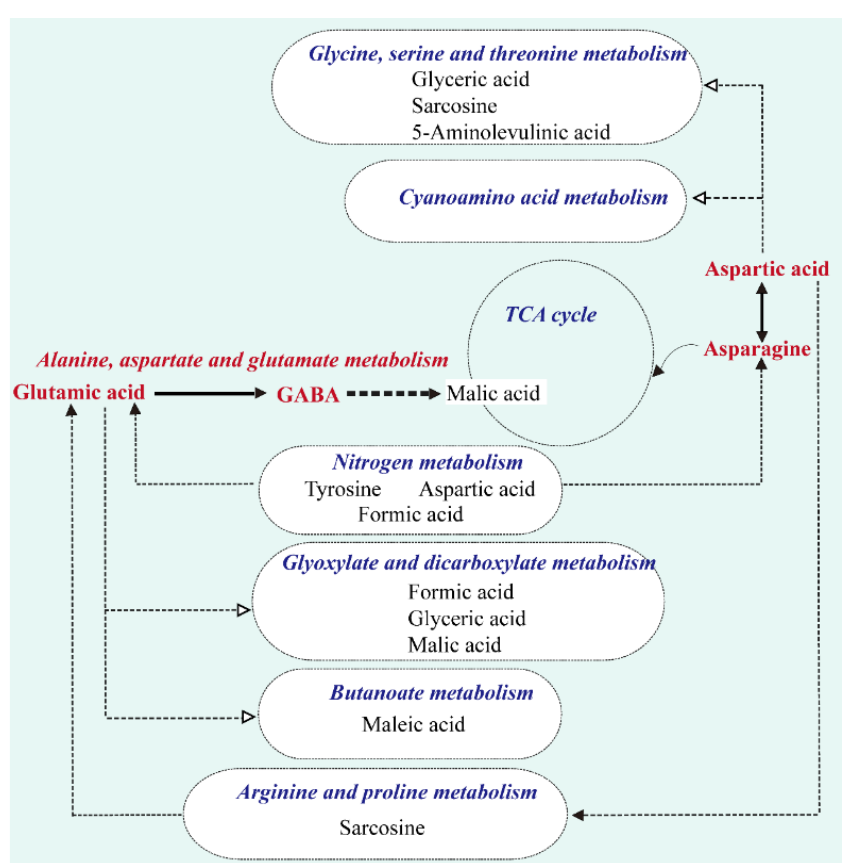
Figure 4. Metabolic network of significantly changed pathways and metabolites. Table 2. Differential metabolites screened from the E-METH and NE-METH groups. Among the above 55 differential metabolites in Table 3, 15 demonstrated normalized trends under induction by exercise and METH. As shown in Table 3, METH reduced the levels of linoleylcarnitine, hexanylcarnitine, sebacic acid, acetylcarnitine, maleic acid, 5-aminolevulinic acid, asparagine, malic acid, and N-acetylneuraminic acid and enhanced the levels of ethylmethylacetic acid, glyceric acid, isovaleric acid, erythronic acid, glutamic acid, and threonic acid. Exercise caused the opposite changes. Additionally, 22 metabolites showed the same trends under the induction of exercise and METH (Table 4). METH and exercise reduced the levels of pentadecanoic acid, DHA, 3-methyl-2-oxopentanoic acid, adrenic acid, phenylpyruvic acid, aspartic acid, suberic acid, DPAn-6, alpha-ketoisovaleric acid, dodecanoic acid, dihomo-gamma-linolenic acid, tyrosine, oleic acid, and DPA but increased the levels of carnitine, dodecanoylcarnitine, decanoylcarnitine, formic acid, methylcysteine, glucaric acid, acetylglycine, and tetradecanoylcarnitine. Here, we listed the differential metabolites related to METH addiction (Table 5), including formic acid, tyrosine, aspartic acid, carnitine, glutamic acid, asparagine and